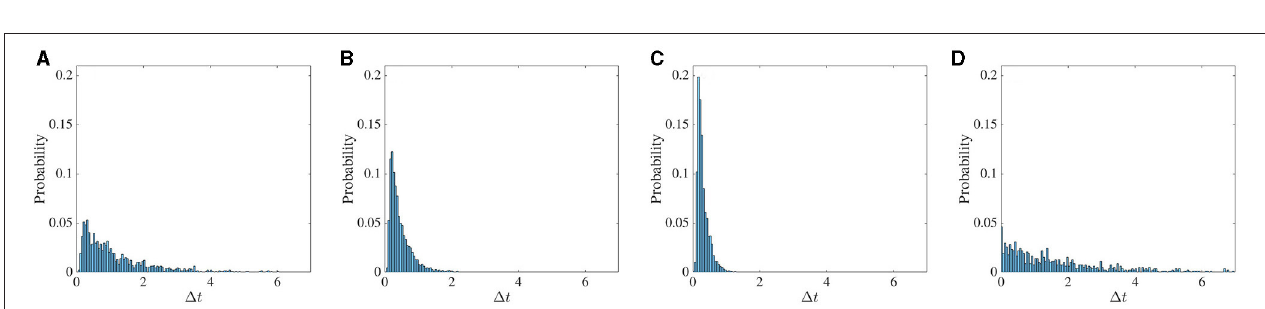
FIGURE 9 | Frequency of chaotic activity dropouts increases with stronger feedback. The probability of intervals between successive low firing activity dropout events. In the first three columns (A–C) , the noise strength is D intensity D 10 − 5 , are added to the excitatory and inhibitory dynamics. In all cases the global feedback time delay T is =